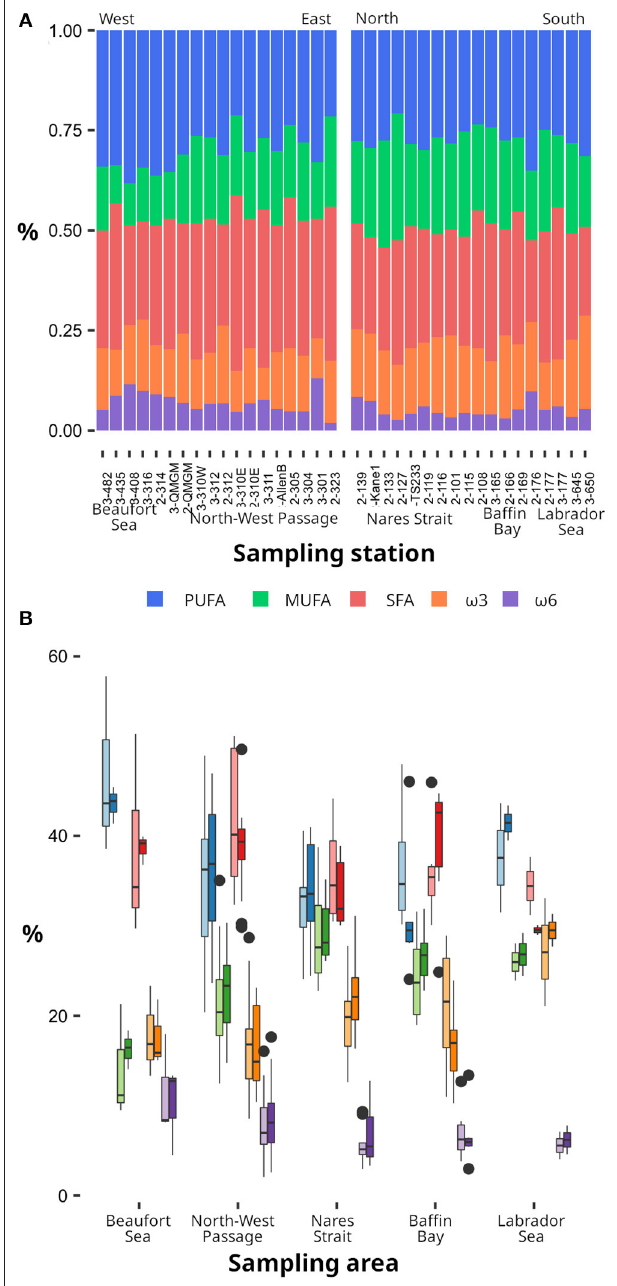
FIGURE 4 | Relative contribution of PUFA, MUFA, SFA, ω 3, and ω 6 fatty acids in particulate organic matter (A) along a longitudinal transect from the Beaufort Sea to the Northwest Passage (left) and a latitudinal transect from Nares Strait to the Labrador Sea (right), and (B) in the different oceanographic regions. In (A) the mean values (i.e., at the SUR and SCM) are represented while in (B) , the light shades represents the SUR and the dark shades represent the SCM.